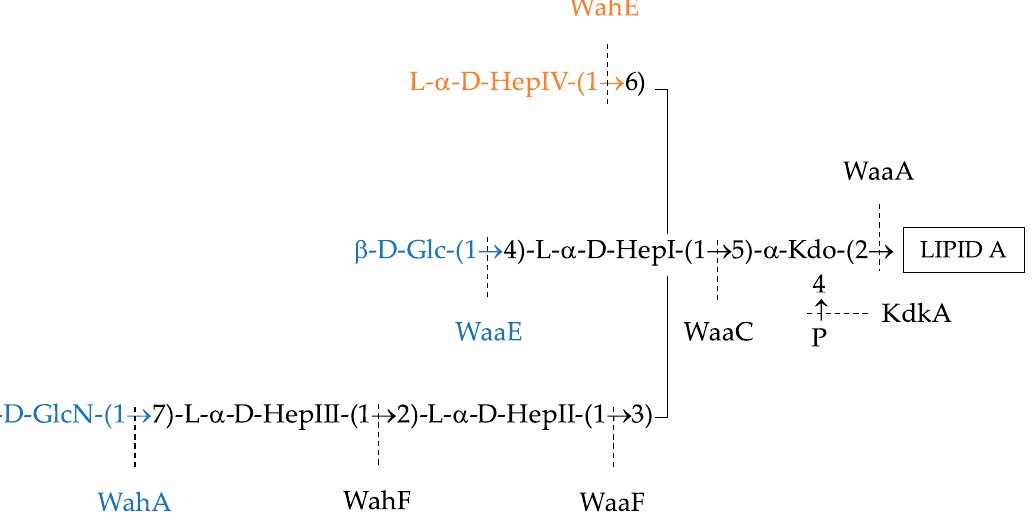
Figure 5. Reconstruction of the Aeromonadaceae common Core-OS. The enzymes found in all genomes are shown in black. WaaE and WahA (in blue), were also present in more than the 90% genomes analysed. Finally, WahE (in orange) is substituted by WahZ (although the carbohydrate linked is still unknown) in the species of the A . veronii monophyletic group.